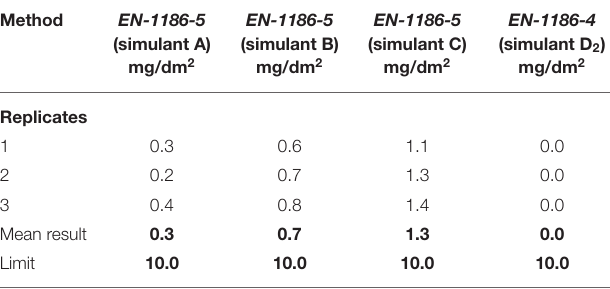
Bold values are the average of results and the limit of measurement.